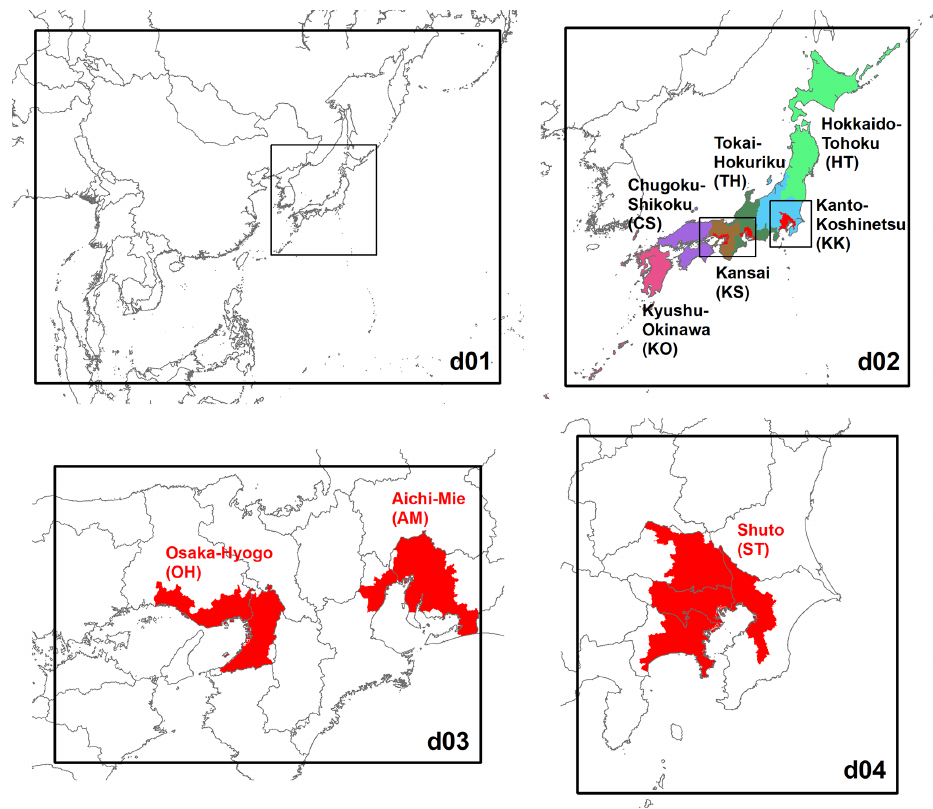
Figure 1. Target domains for the simulations in this study. Results are summarized for six colour-coded regions in d02 and three designated areas shown in red in d02, d03, and d04. Their abbreviations are shown in